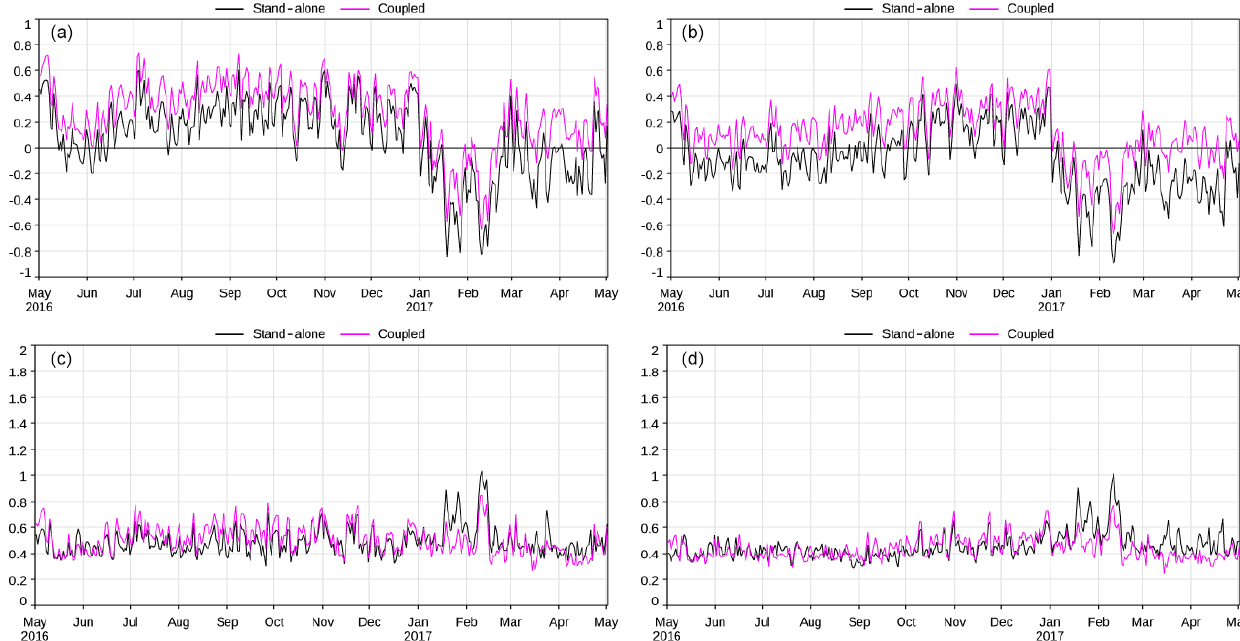
Figure 13. MNMB (a, b) and FGE (c, d) of daily near-surface PM 2 . 5 (a, c) and PM 10 (b, d) (µgm − 3 ) simulated by stand-alone (black) and coupled (violet) cycle 45R1 against European observations from the AirBase network.